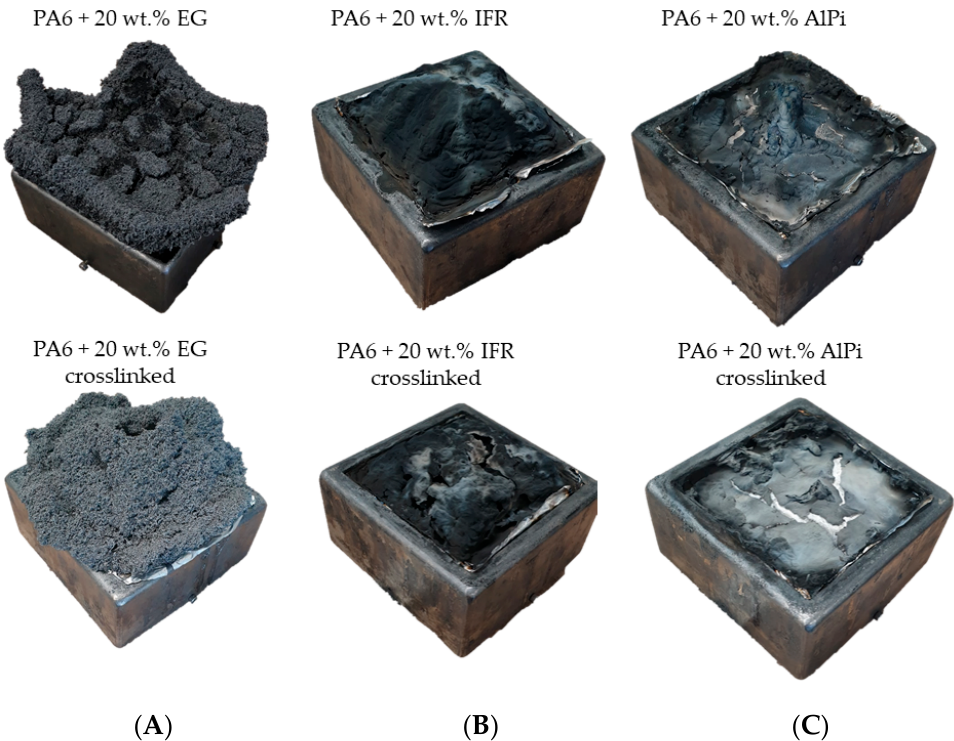
Figure 18. Char residues of non ‐β‐ RC and β‐ RC materials after full decomposition within cone calorimeter tests (50 kW/m 2 ). ( A ) PA6/EG, ( B ) PA6/IFR, and ( C ) PA6/AlPi.